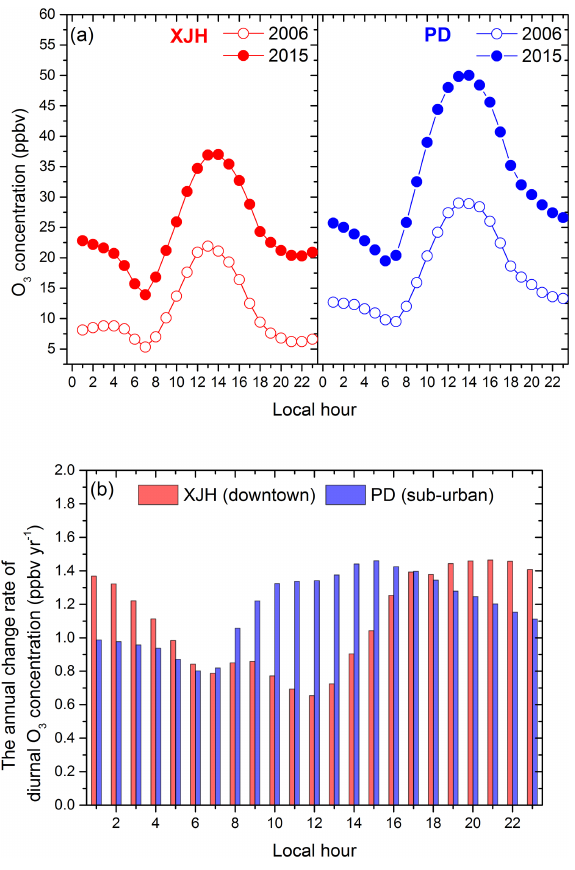
Figure 6. (a) The mean diurnal variation in O 3 concentration (ppbv) compared between 2006 and 2015 in XJH (red dots) and PD (blue dots). (b) The annual change rate of diurnal O 3 concentration (ppbvyr − 1 ) from 2006 to 2015 at the downtown site XJH (red bars) and sub-urban site PD (blue bars).